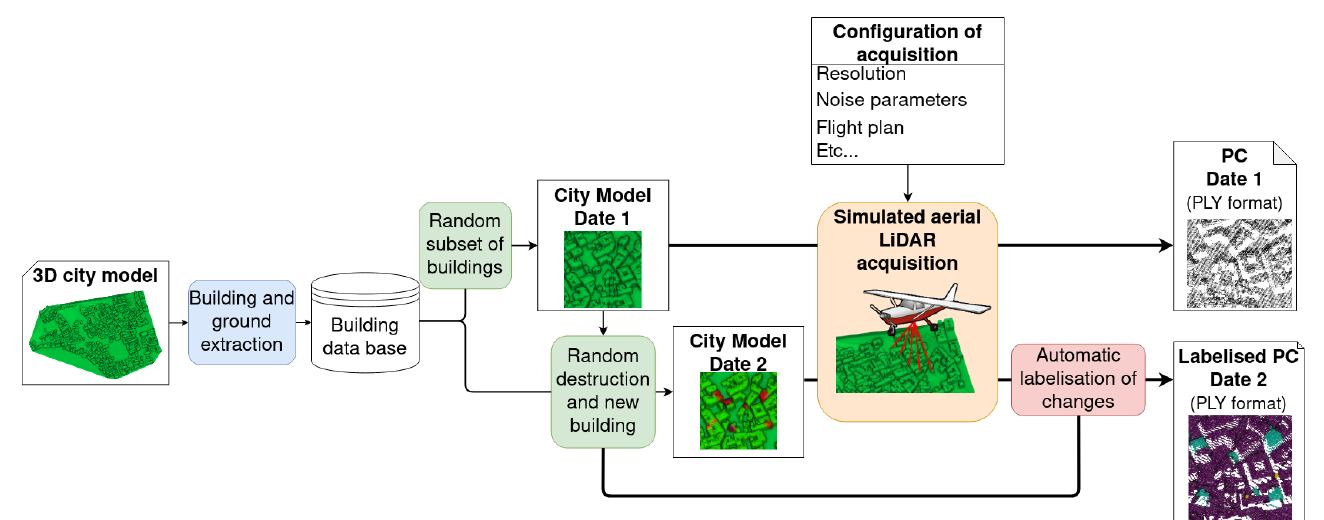
Figure 1. Overall framework of our simulator generating bi-temporal urban 3D point clouds.